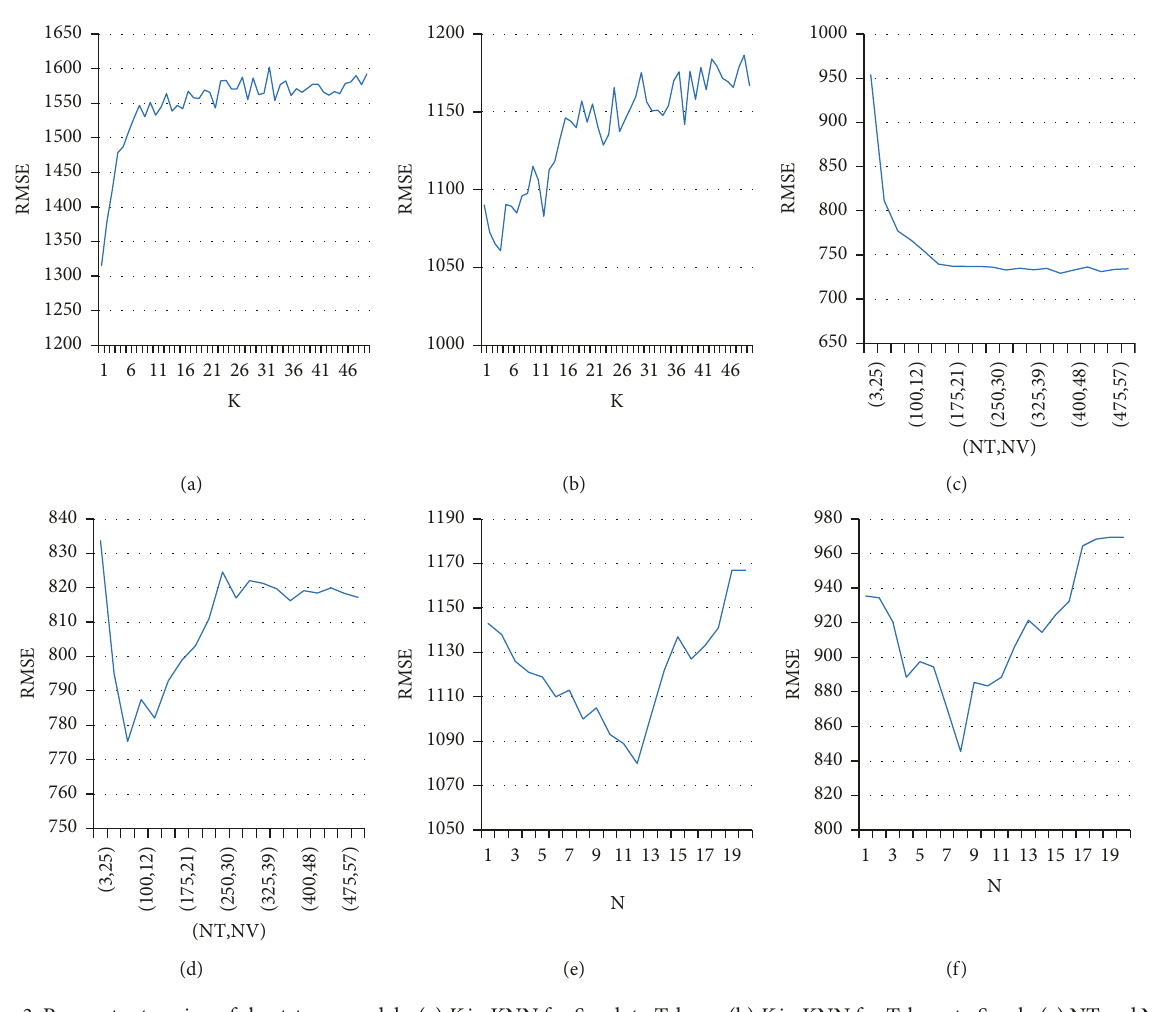
Figure 3: Parameter tunning of short-term models. (a) K in KNN for Saveh to Tehran. (b) K in KNN for Tehran to Saveh. (c) NTand NV in RF for Saveh to Tehran. (d) NT and NV in RF for Tehran to Saveh. (e) N in RNN for Saveh to Tehran. (f) N in RNN for Tehran to